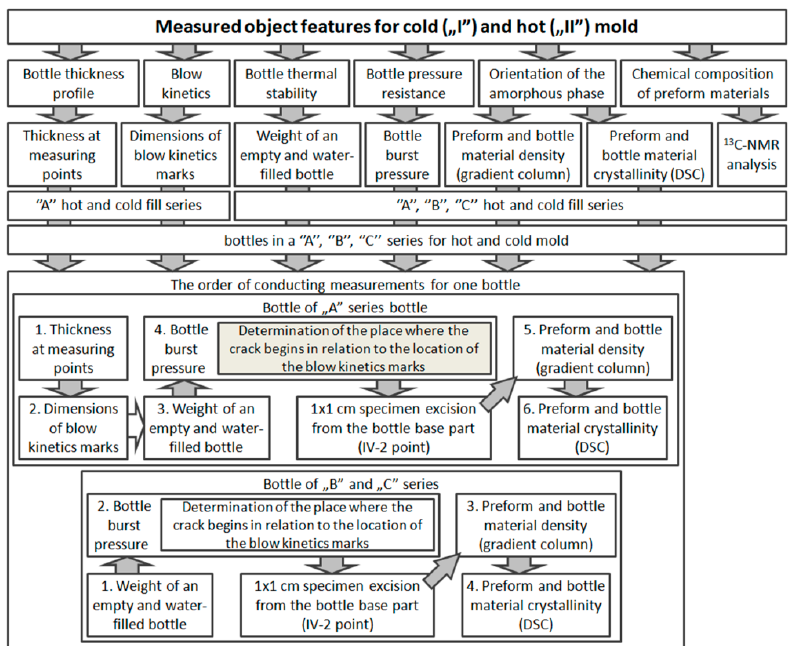
Figure 7. The order of testing the thickness profile, dimensions of the markers of the kinetics of blowing, thermal stability, pressure resistance, and relaxation of the amorphous phase of the bottle intended for cold and hot